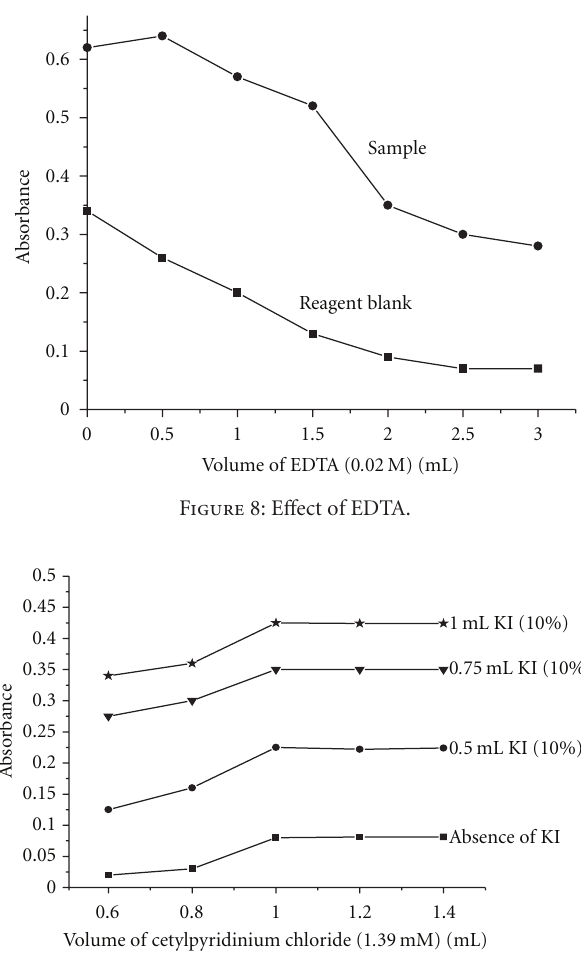
Figure 9: Phase diagram of the CPC, water, and KI ternary system.